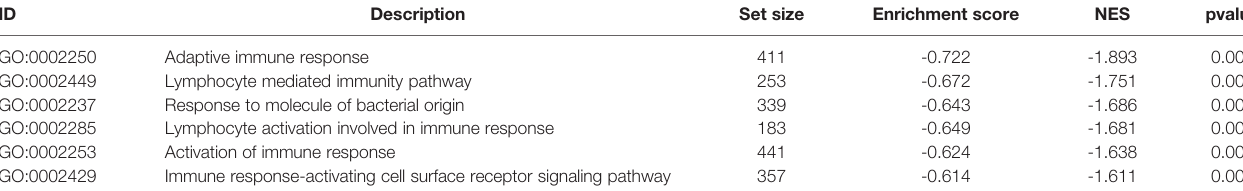
TABLE 2 | The enriched biological process associated with the